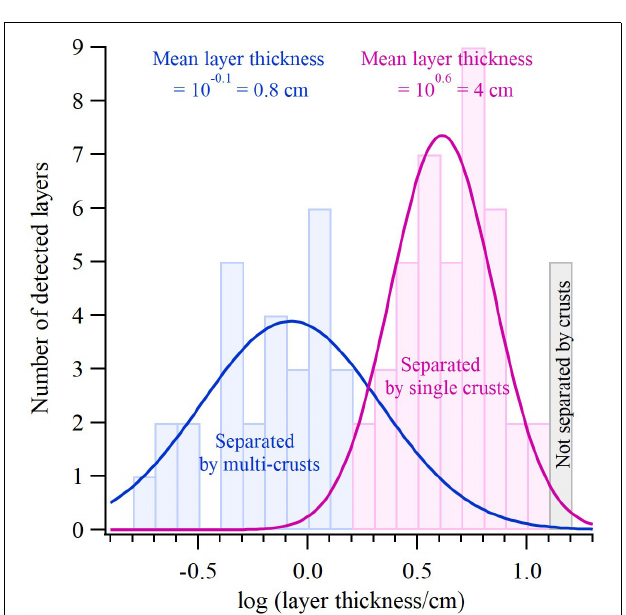
FIGURE 4 | Bimodal Gaussian distribution of logarithmic layer thickness for the deposited layers of the snow profile near Kohnen Station; the mean layer thickness in multi-crust-clusters centers at 0.8 cm; layers confined by single crusts have an average thickness of 4 cm; sections separated by changes in density but without internal crusts lie at the top tail of the Gaussian distribution.